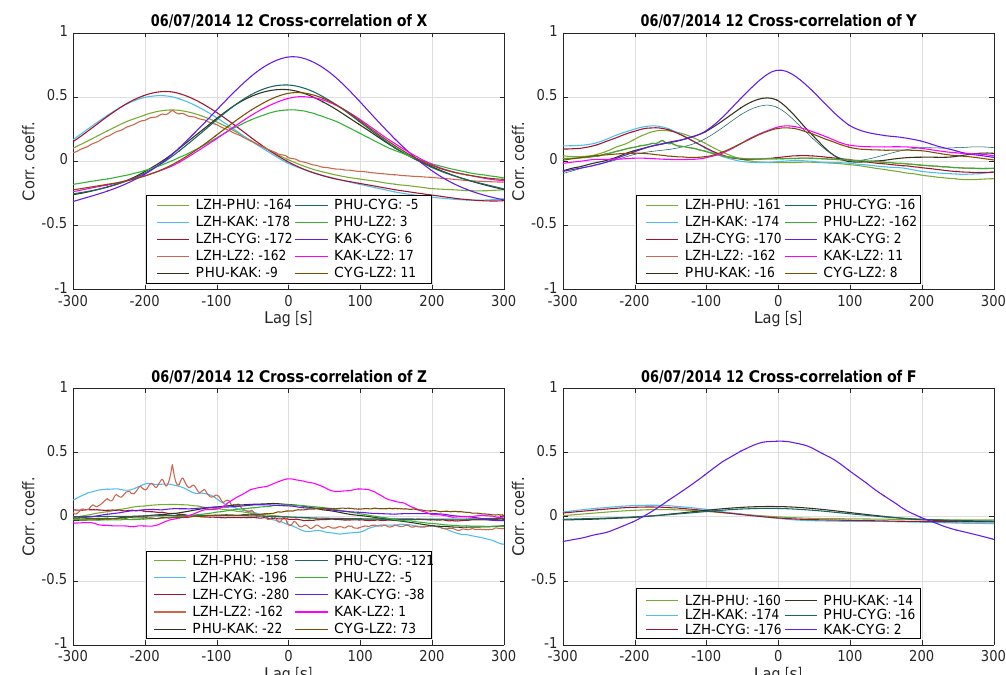
Figure 2. Cross-correlation between all analysed observatories over 1h of data (11:30–12:30UTC) on 6 July 2014, one of the last days without GPS synchronization for LZH data logger. The second acquisition system of Lanzhou observatory is labelled